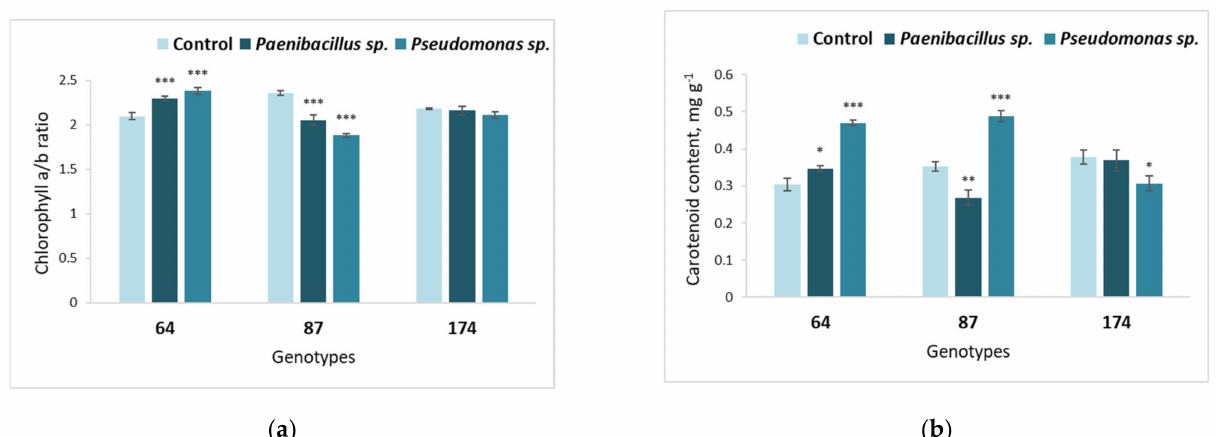
Figure 4. Average chlorophyll a/b ratio ( a ) and carotenoid content ( b ) in the leaves of different F. excelsior genotypes (64, 87 and 174), inoculated with Paenibacillus sp. and Pseudomonas sp. bacteria. Statistically significant differences from the bacterium-free control variant are indicated (for each genotype separately): * p < 0.05; ** p < 0.01; *** p < 0.001.